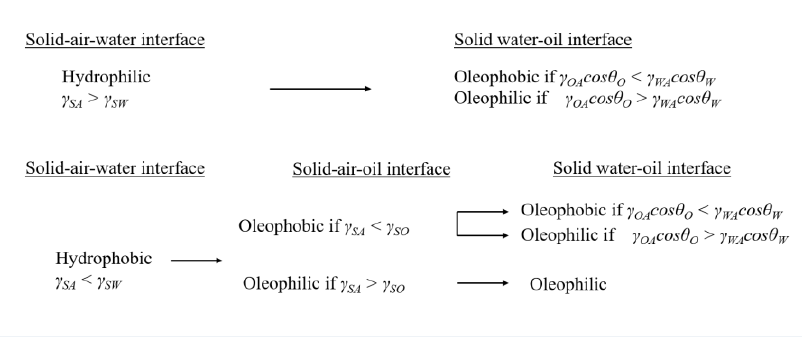
Figure 7. Summary of “Philic”/“Phobic” natures at various interfaces.